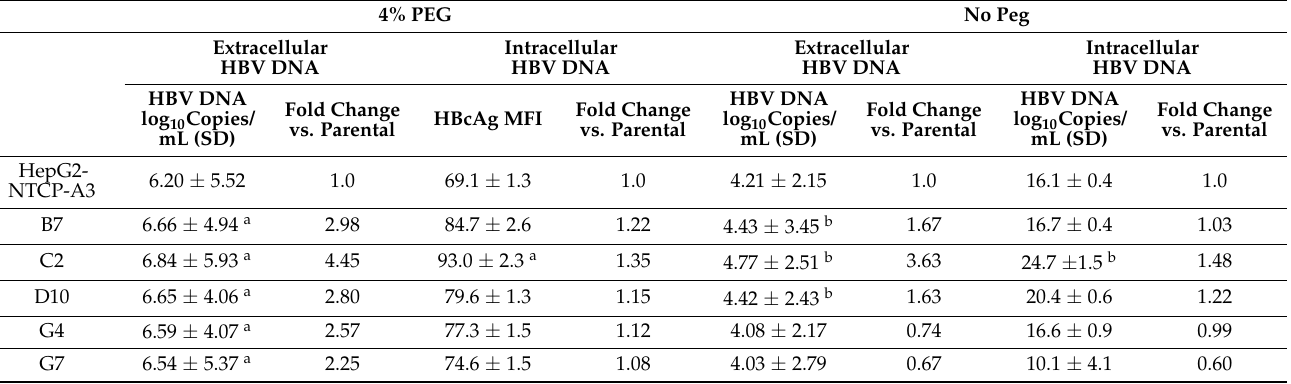
Table 1. Comparison of HBV infection in the presence or absence of PEG in HepG2-NTCP parental clone and its subclones. 4% PEG No